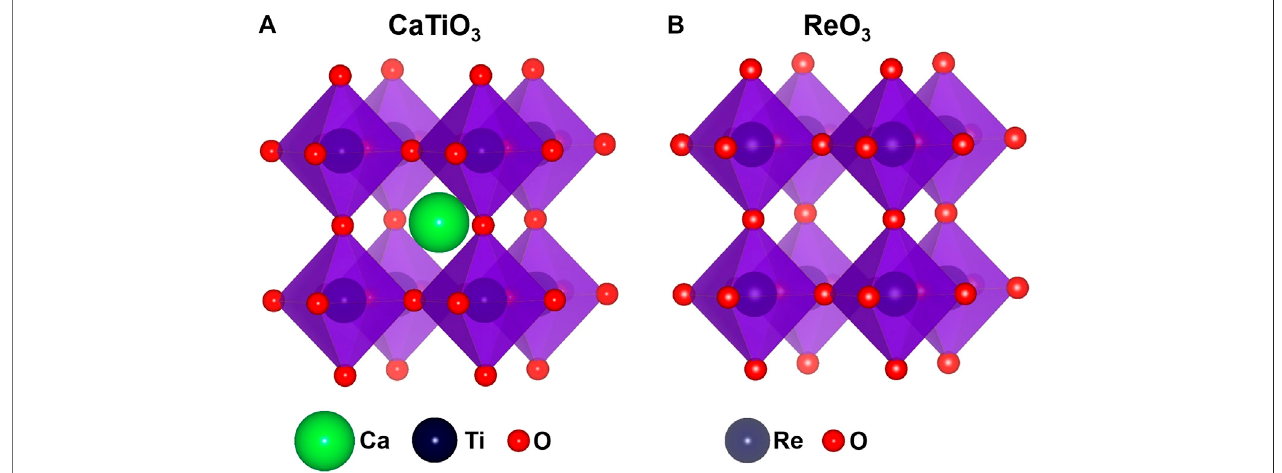
FIGURE 4 | (A) CaTiO 3 perovskite structure and (B) ReO 3 structure with empty cuboctahedral A-site.